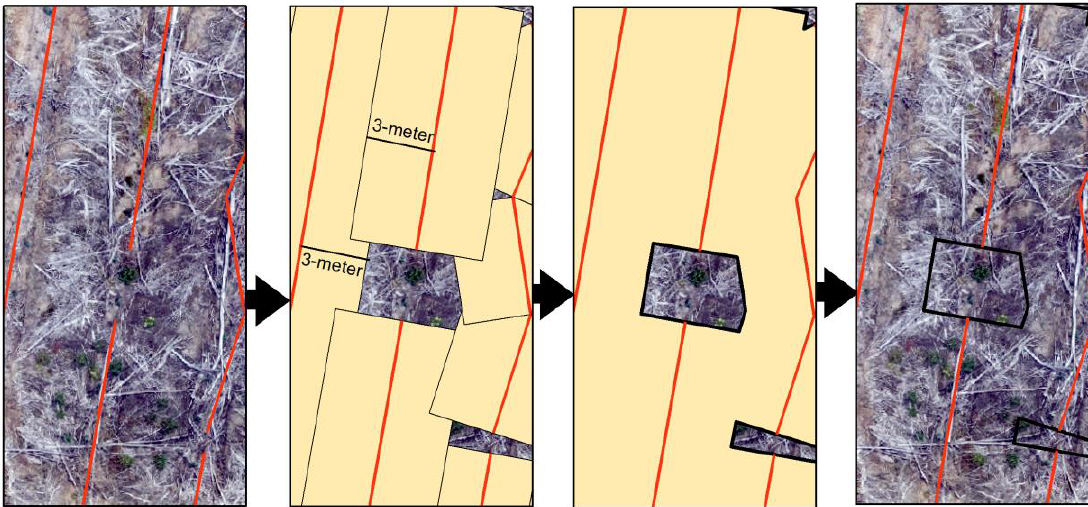
Figure 14. Illustration of compromised plantation-row identification. Overlapping buffers were generated to find the gaps in extracted plantation-rows. The gap identification is helpful to identify the compromised locations of plantation-rows.